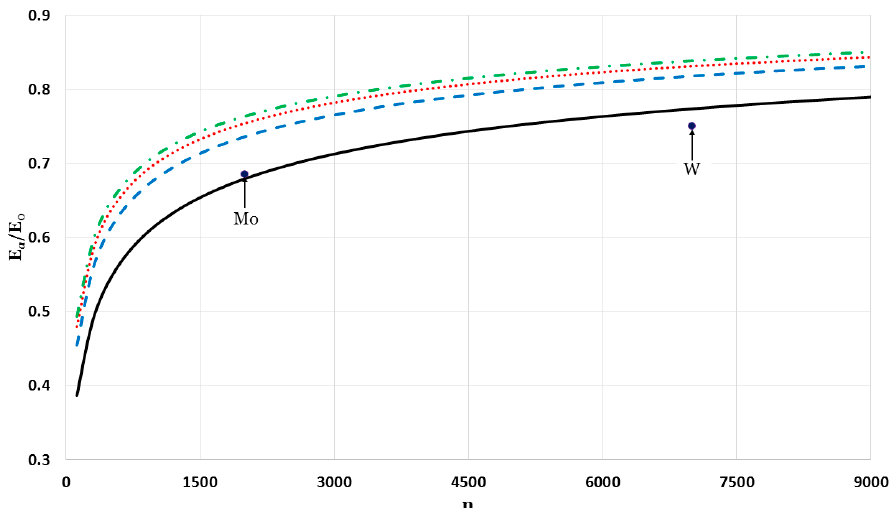
Figure 5. The variation of the relative cohesive energy of nanoparticles in a face-centered cubic structure as function of the number of atoms for α = 2.4 and di ff erent values of m : 2 (black solid line), 3 (blue dashed line), 4 (red dotted line), and 5 (green dashed-dotted line). The experimental values [23,24] are denoted by dark blue circles. Energies 2020 , 13 , x FOR PEER REVIEW 7 of 16